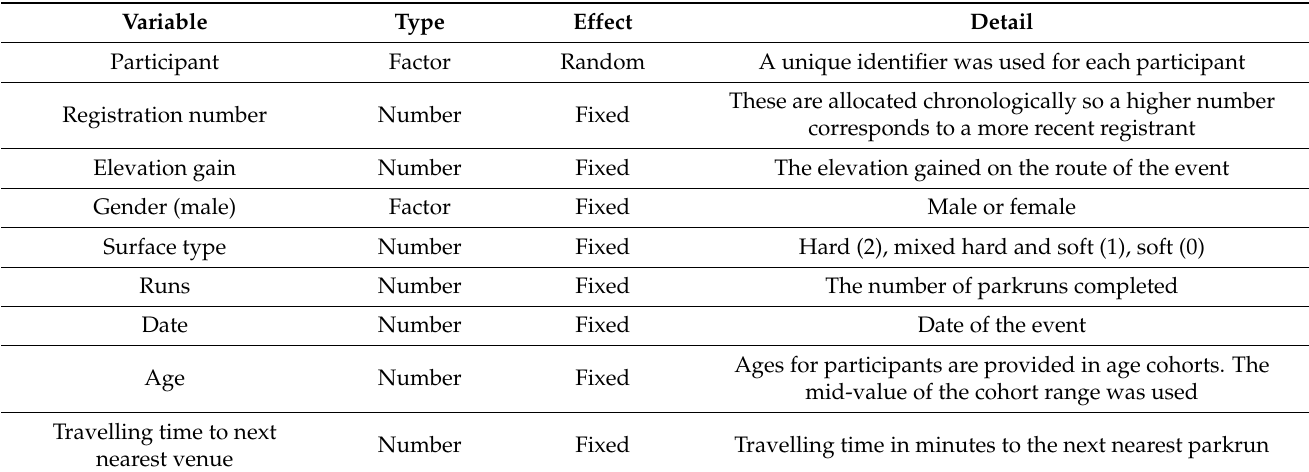
Table 1. A list of the predictor variables included in the AGPS